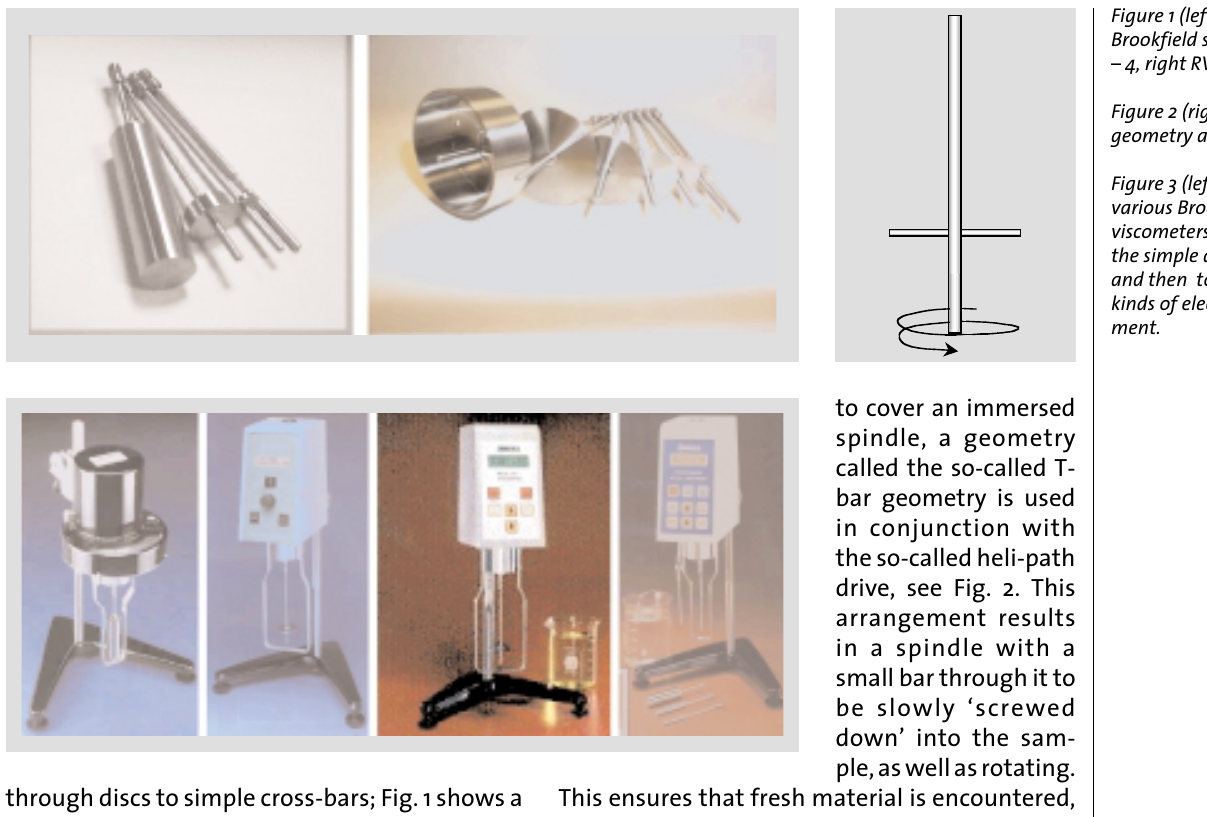
Figure 1 (left above): Popular Brookfield spindles: left LV 1 – 4, right RV1 – 7. Figure 2 (right above): T-bar geometry and operation. Figure 3 (left below): The various Brookfield ‘dip-in’ viscometers; on the left is the simple analogue version and then to the right three kinds of electronic instru- ment.